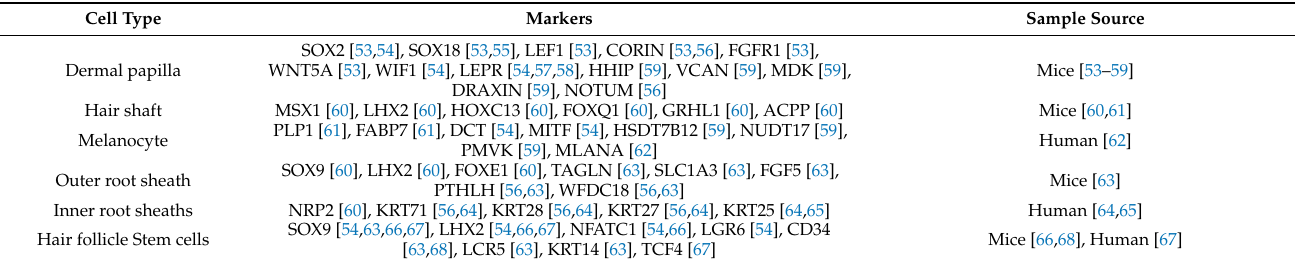
Table 1. Markers for identification of major cell types in hair